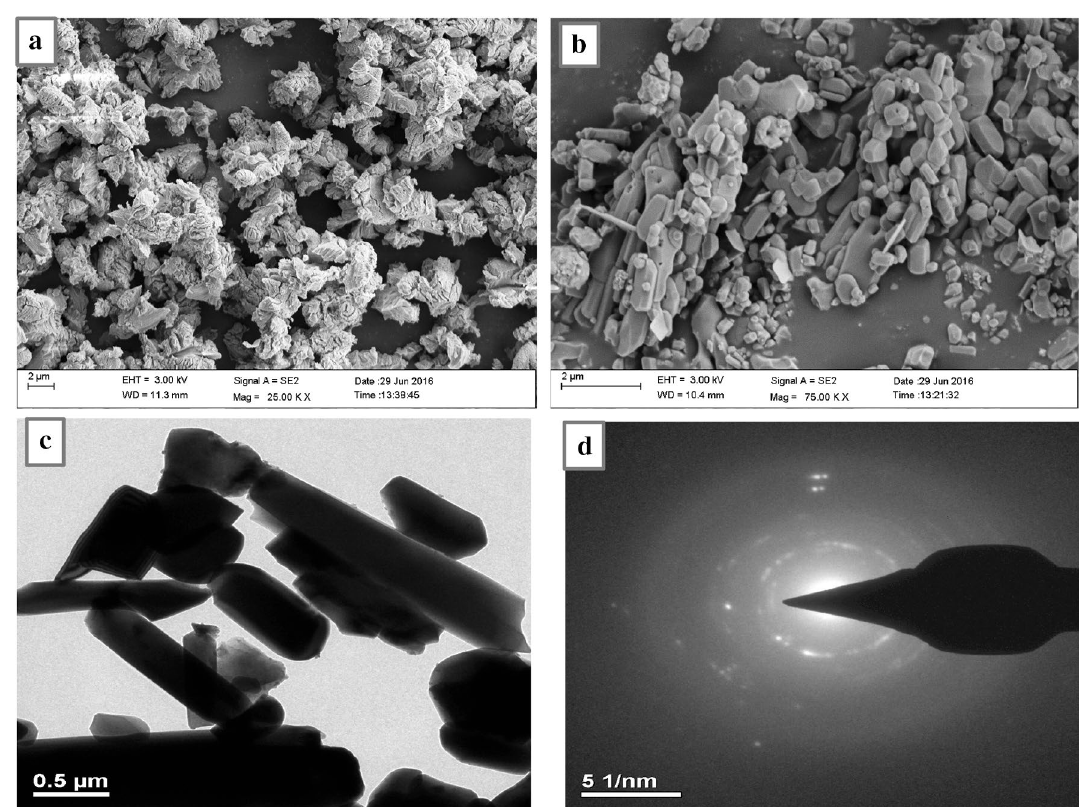
Fig. 6 FE-SEM images of a snail shell powder, b carbonated apatite, c TEM image and d SEAD of carbonated apatite powder